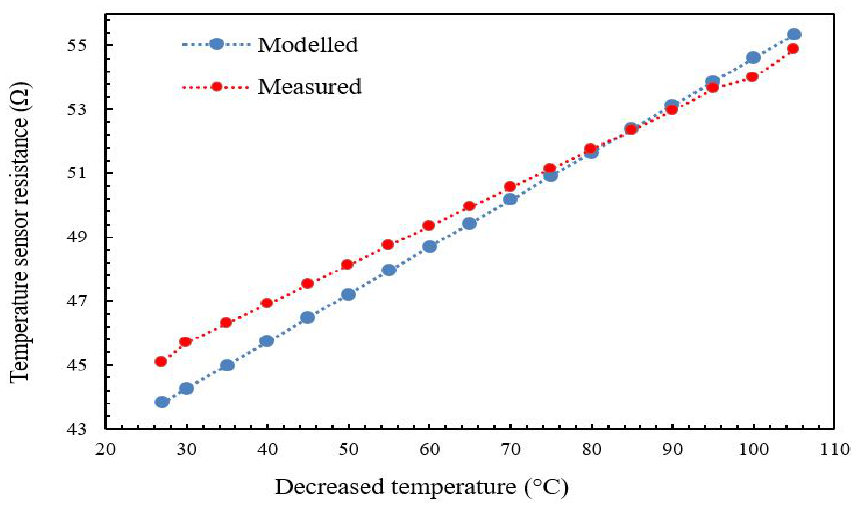
Figure 16. Modeled and experimental for the temperature sensor (gold) versus decreasing temperature.